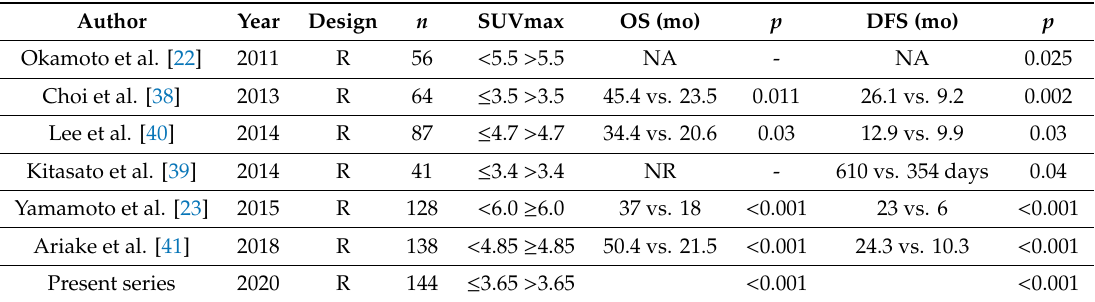
Table 4. The Literature Reporting Di ff erences in Overall Survival and Disease-Free Survival by